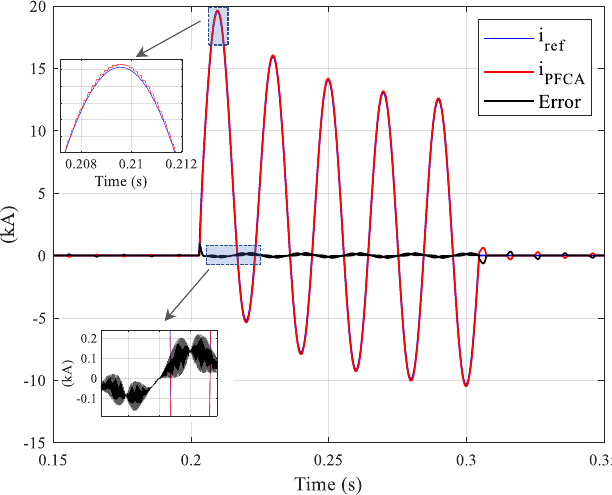
Figure 15. Current error, current reference waveform, and PFCA output current (phase a).